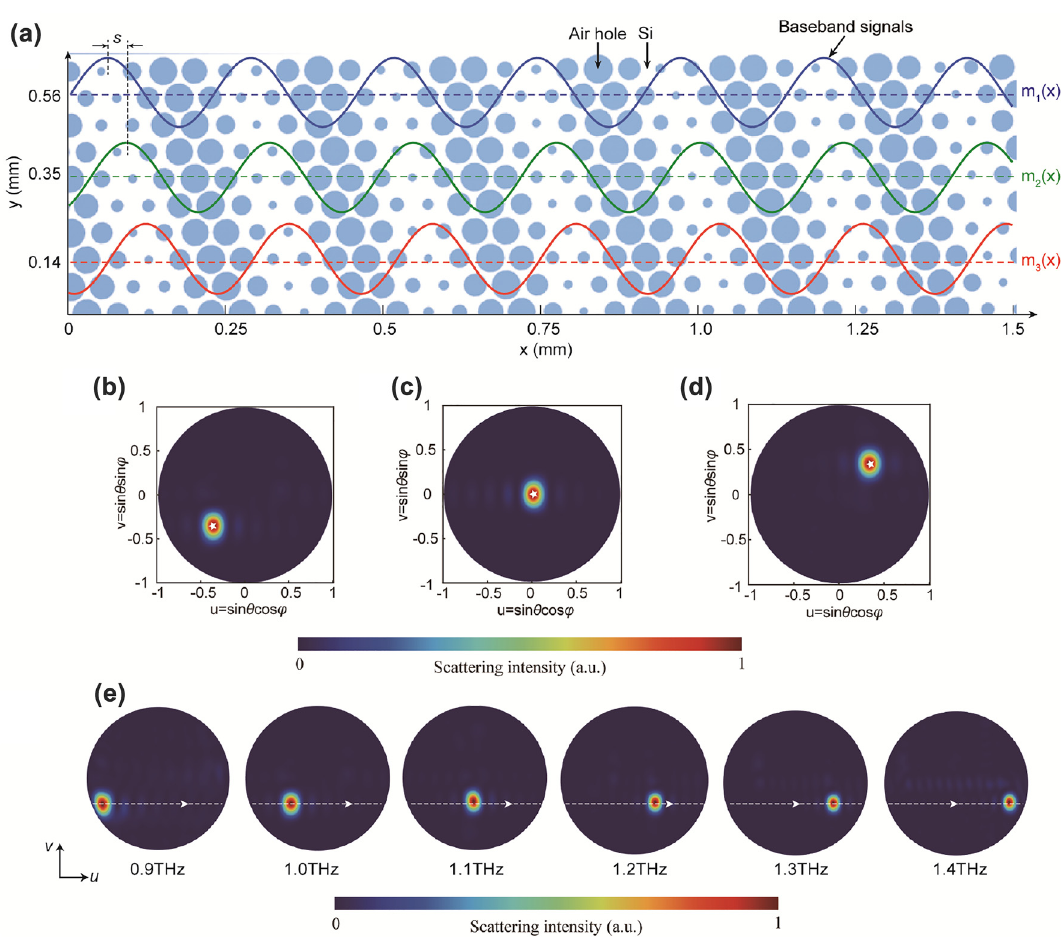
Figure 4: Arbitrary direction deflection. (a) Baseband signal distributions with space shifts s along the y -direction. The radii of the air-holes are synthesized according to the baseband signals. (b to d) Simulated scattering patterns in uv -space at 1 THz by introducing different x - and y -direction tangential momentums ( 𝜉 directions are marked as white stars. (e) Simulated scattering patterns in uv -space from 0.9 to 1.4 THz with an increment of 0.1 THz. The white dashed line depicts the theoretical frequency-scanning trajectory of the output